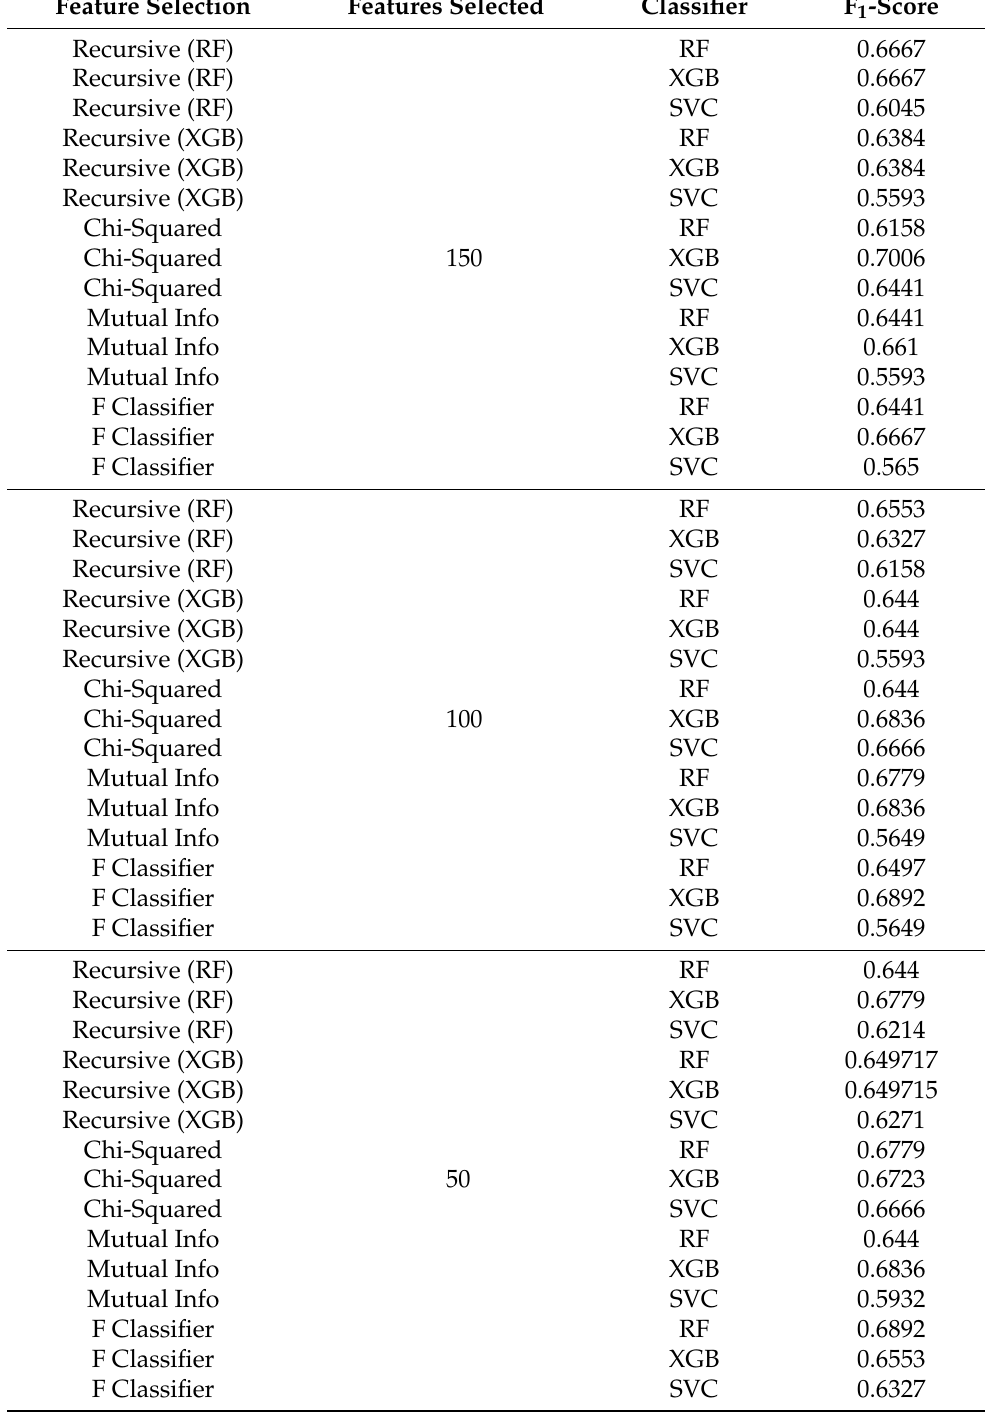
Table 3. F 1 scores obtained by using GloVe pre-trained embeddings and selecting 150, 100, and 50